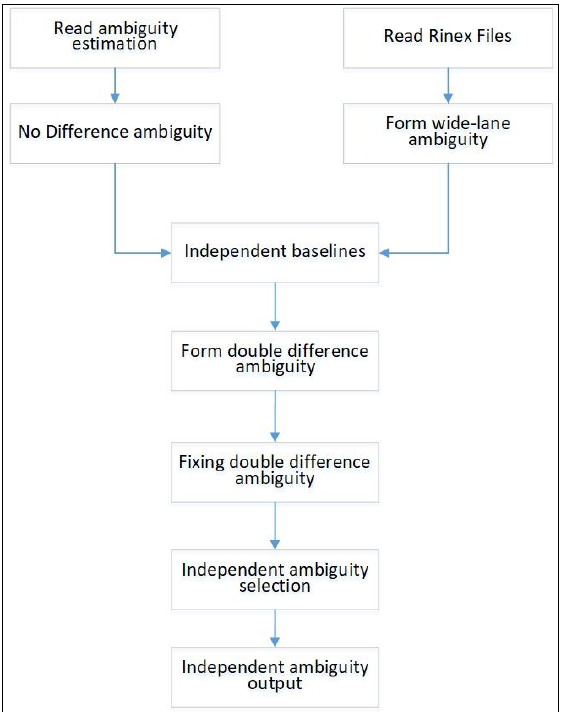
Figure4 . Ambiguity fixing